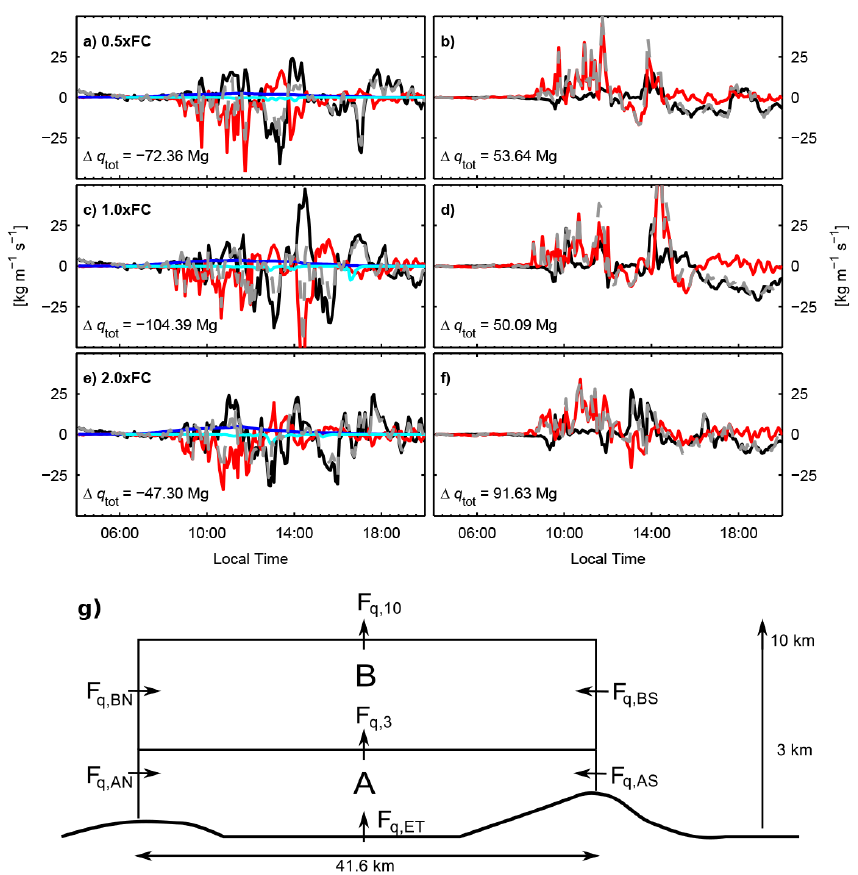
Figure 11. Instantaneous moisture flux f q [kgm − 1 s − 1 ] for Nam Co Lake basin. (a, c, e) Moisture transport into control volume A, as indicated in (g) of this figure, representing the Nam Co Basin up to 3kma.g.l.: evapotranspiration (blue); precipitation (cyan); net horizontal flux (black); net vertical flux (red); and resulting total flux (grey, dashed). The precipitation flux is not displayed as it is of negligible magnitude. (b, d, f) Transport into the mid-tropospheric control volume B with the same horizontal extent and from 3 to 10km vertical extent; (g) is a schematic drawing of the control